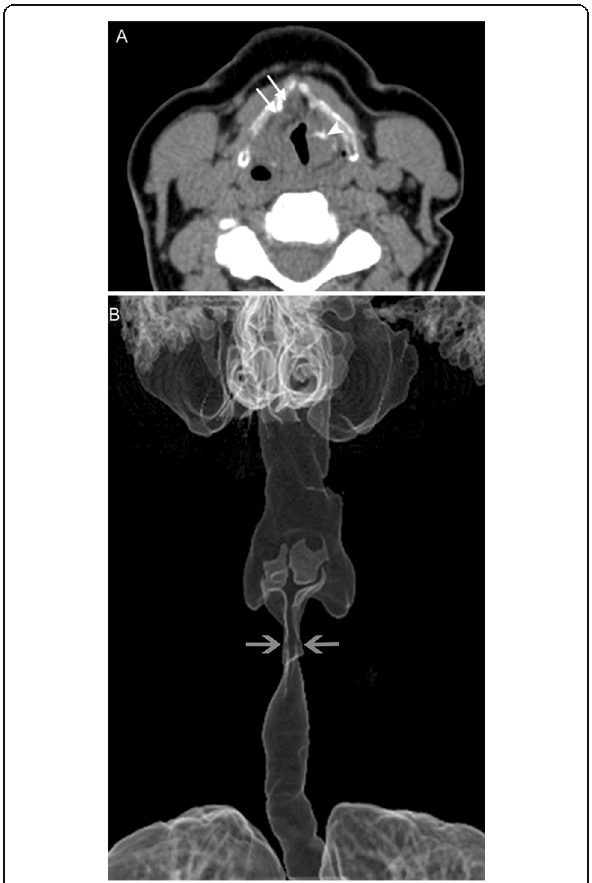
Fig. 9 Laryngeal amyloidosis. A 69-year-old woman with recurrent laryngeal amyloidosis despite multiple interventions. Axial CT image ( a ) reveals marked soft tissue thickening of the laryngeal structures extending into the right pre/paraglottic space (white arrows) representing amyloid infiltration, and dystrophic calcification (white arrowhead) representing post-treatment change. The true vocal cords are not identifiable. 3D surface volume rendering ( b ) demonstrates marked narrowing of the glottic airway (gray